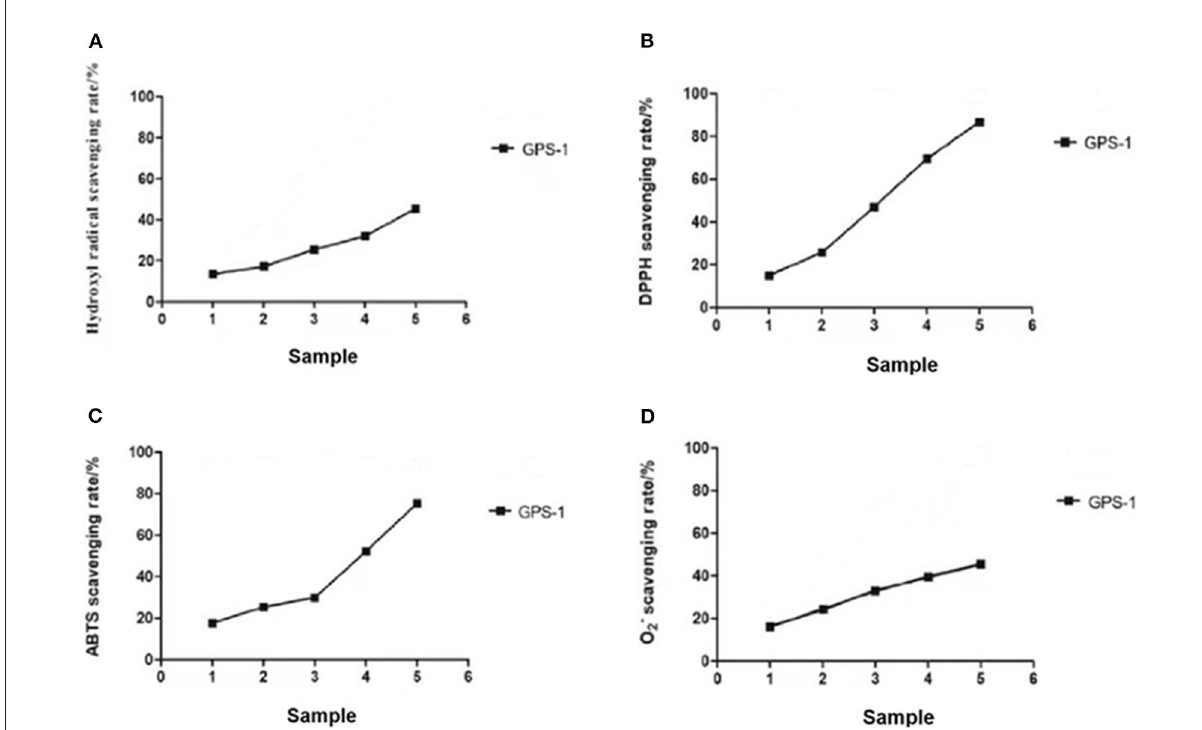
FIGURE5 The hydroxyl radical-removing rate (%) (A) The DPPH radical-removing rate (%) (B) The ABTS radical-removing rate (%) (C) Superoxide anion radical-scavenging rate (%) (D) Sample numbers 1–5 correspond to the concentration of GPS-1 2.44, 4.88, 9.77, 19.53, and 39.06 µ g/mL, respectively.